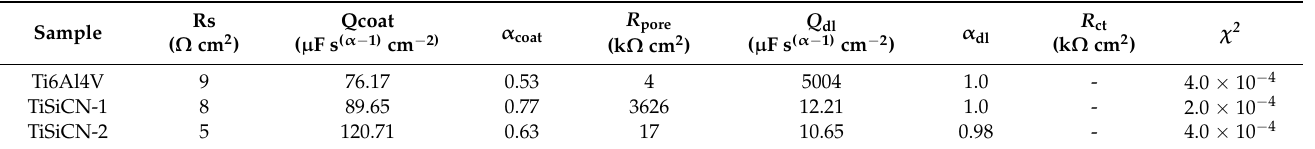
Table 3. The fitting results of EIS data for the investigated samples after 1 h immersion in 3.5% NaCl.